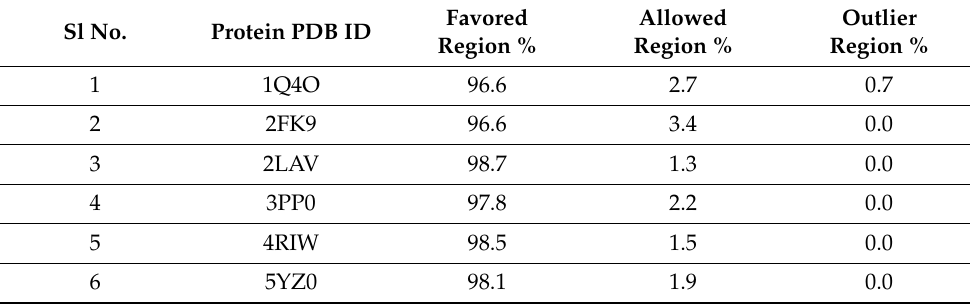
Table 1. The RAMPAGE results for all the selected proteins. Sl